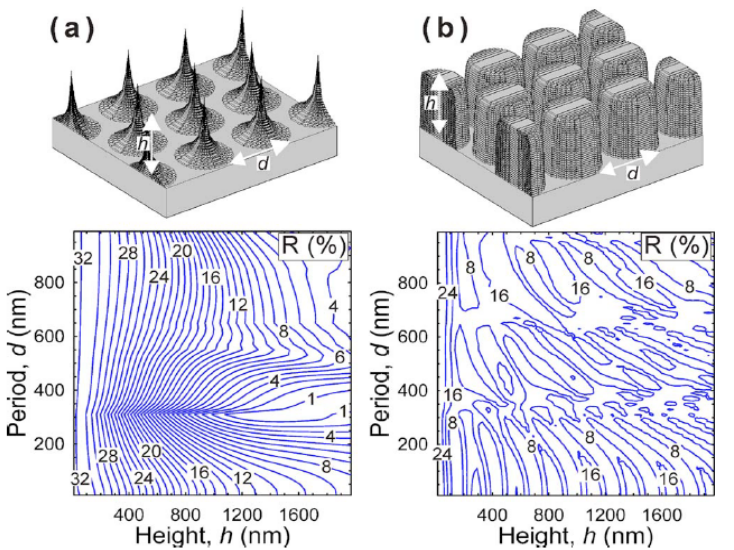
Figure 21. Several moth-eye-like structures with different refraction index profiles and their associated reflectance vs . period and height at a wavelength of 1000 nm. Reprinted with permission from reference [72], Copyright 2008 AIP